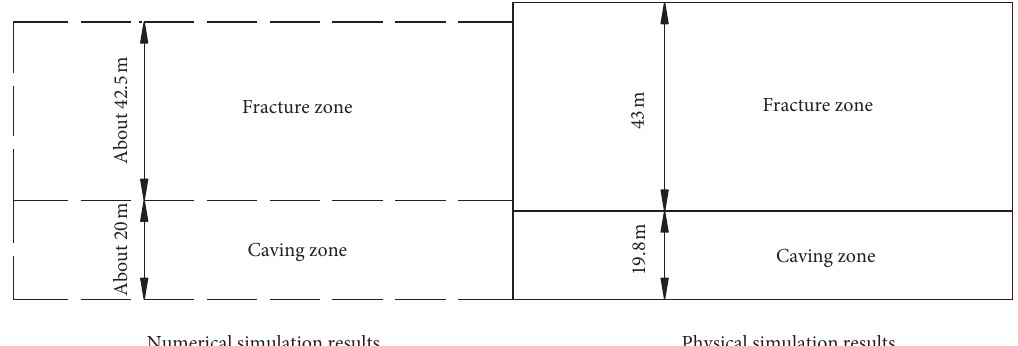
Figure 17: Comparison of physical simulation results and numerical simulation